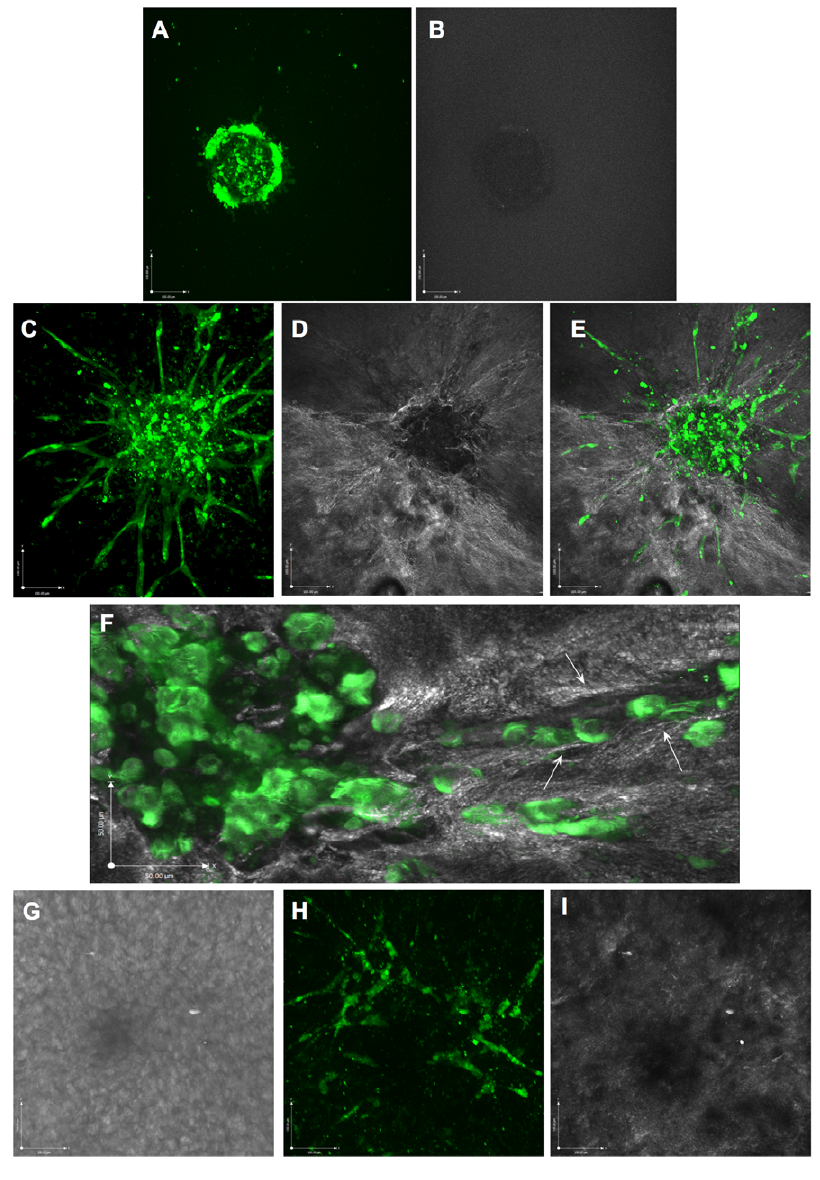
Figure 2. Multiphoton microscopy images of Minitumour spheroids after 40 h or 7 days culture. A - HUVECs dyed with a CMFDA Green CellTracker dye were imaged within the Minitumour spheroid immediately following their embedding into the type-I collagen matrix using a Multiphoton microscope with a 20 6 objective. B – Immediately after collagen embedding, the collagen-I gel emits a weak homogenous Second Harmonic Generation (SHG) signal. C – Multiphoton imaging from of spheroids after 40 h incubation in the collagen-I gel shows the formation of green endothelial sprouts into the collagen matrix. D - The SHG signal from the collagen reveals an increase in matrix intensity around the endothelial sprouts. E – Merged image between CMFDA Green CellTracker dye and SHG signals after 40 h incubation. F – A higher amplification (40 6 ) image of an endothelial cell sprout from a Minitumour spheroid after 40 h shows the alignment of collagen fibrils along the endothelial cell sprout (white arrows). G – Phase contrast images after 7 days incubation in the collagen-I gel showing a homogenous layer of cells. H – Multiphoton imaging after 7 days incubation shows the formation of a network of pre-dyed endothelial cells within the layer of cells. I – SHG signal from the collagen matrix after 7 days spheroid incubation. Scale bars represent 50 m m in F and 100 m m in all others.